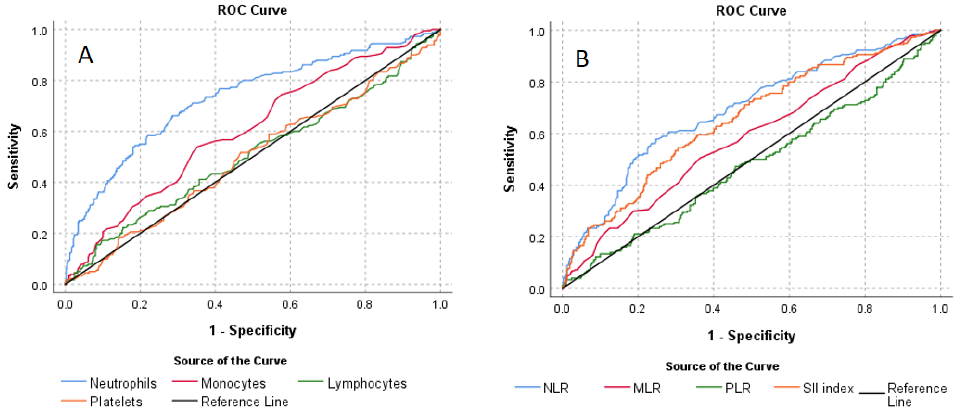
Figure 2. ROC curves of the of white blood cells, platelets ( A ) and Inflammatory Ratios ( B ).